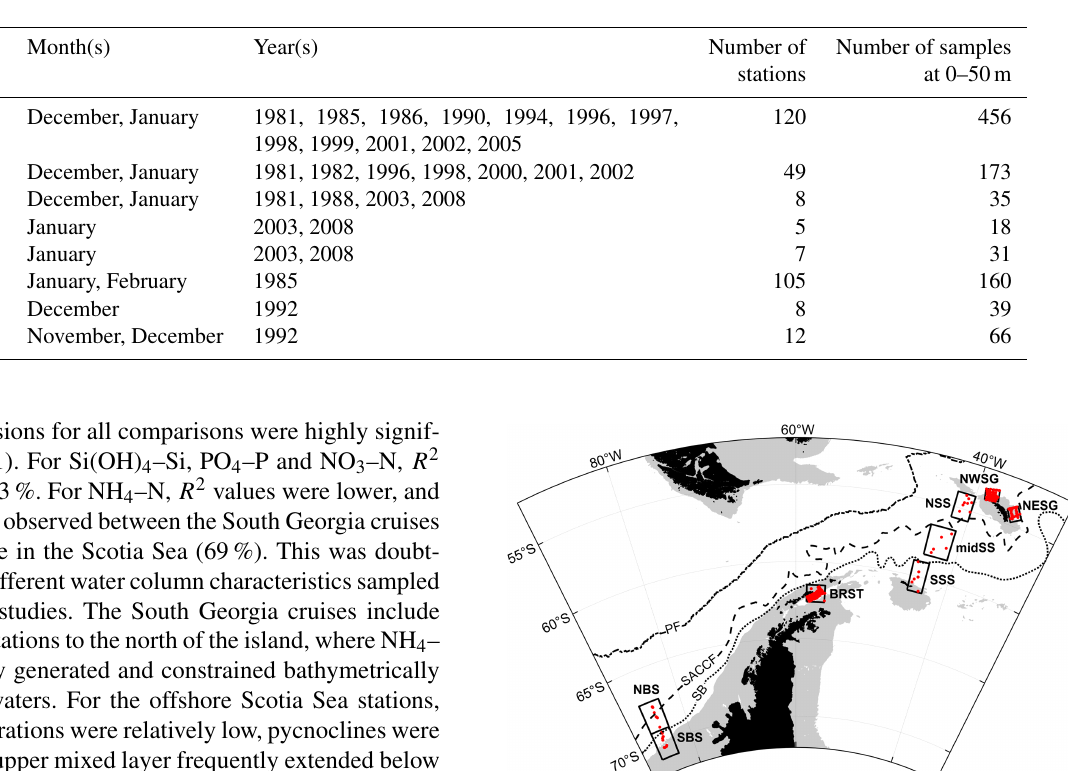
Table 4. Details of the profile samples used to derive the austral summer properties for 0–50m (Fig. 8). Refer to Fig. 7 for locations. Number of samples refers to the number of Niskin bottles for which at least one inorganic nutrient was analysed for the given location, months and depth range.